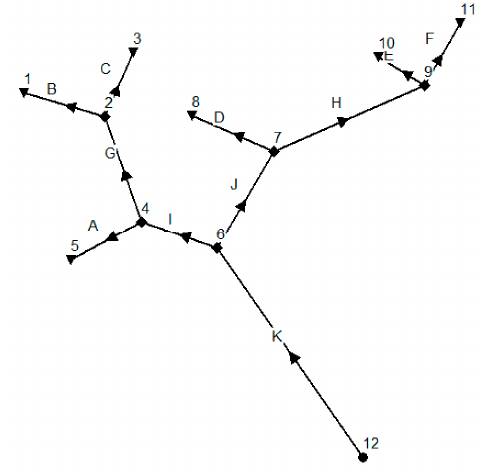
Figure 4. Hypothetical river network B. Table 4. Pollution detection time for river network B with a detection threshold of 0.01 mg/L.